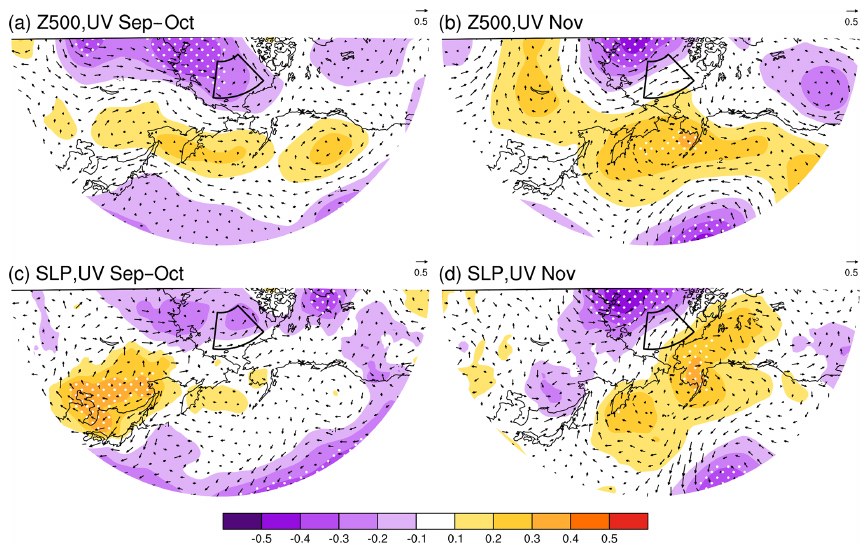
Figure 6. The CC between BSISO and September–October (a) geopotential height (shading), wind (arrow) at 500hPa, (c) SLP (shade) and surface wind (arrow) and between BSISO and November (b) geopotential height (shading), wind (arrow) at 500hPa, (d) SLP (shade) and surface wind (arrow) from 1979 to 2015, after detrending. The white dots indicate CCs exceeding the 90% confidence level ( t test). The black box in panels (a) – (d) represents the location of the Beaufort Sea.